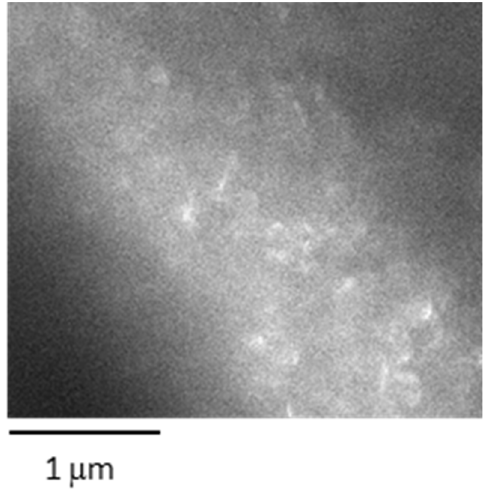
Figure 2. SEM images of the slippery surface (SLS) surface, SE, 20,000 ×.